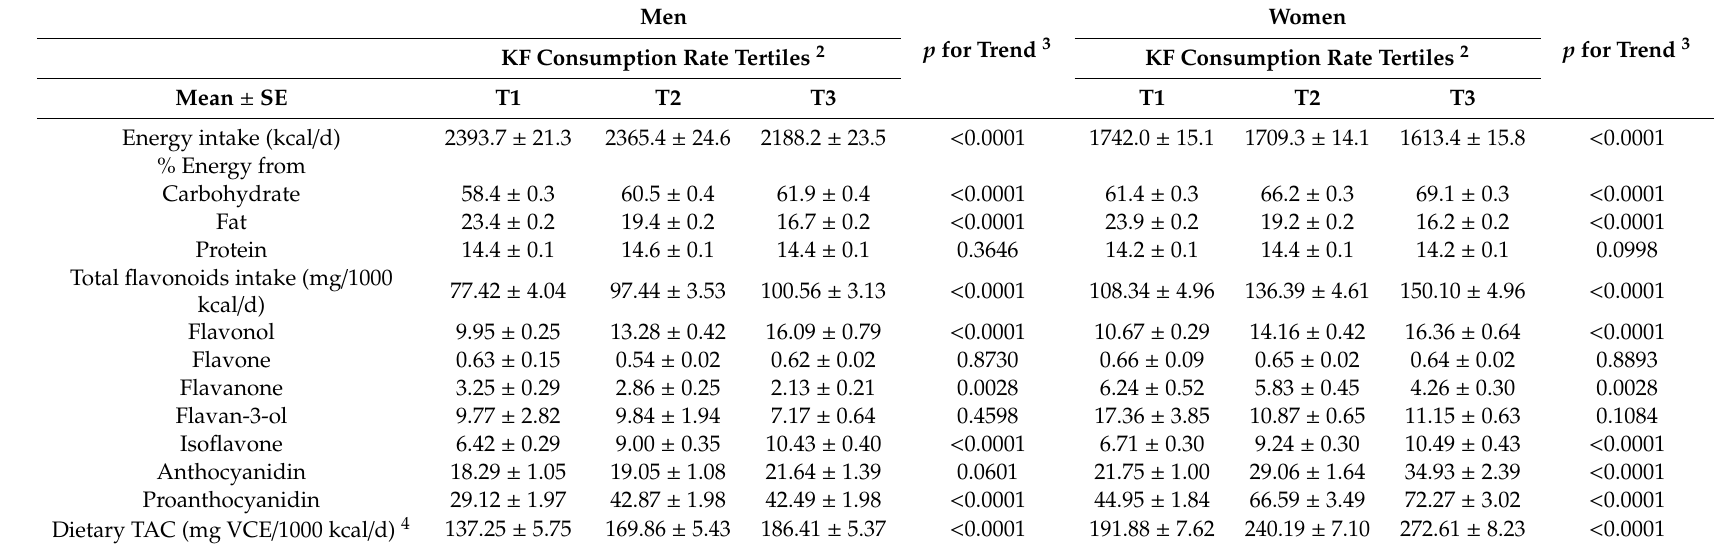
Table 3. Dietary intake of macronutrients, flavonoids, and dietary total antioxidant capacity (TAC) according to tertile groups of Korean food (KF) consumption rate 1